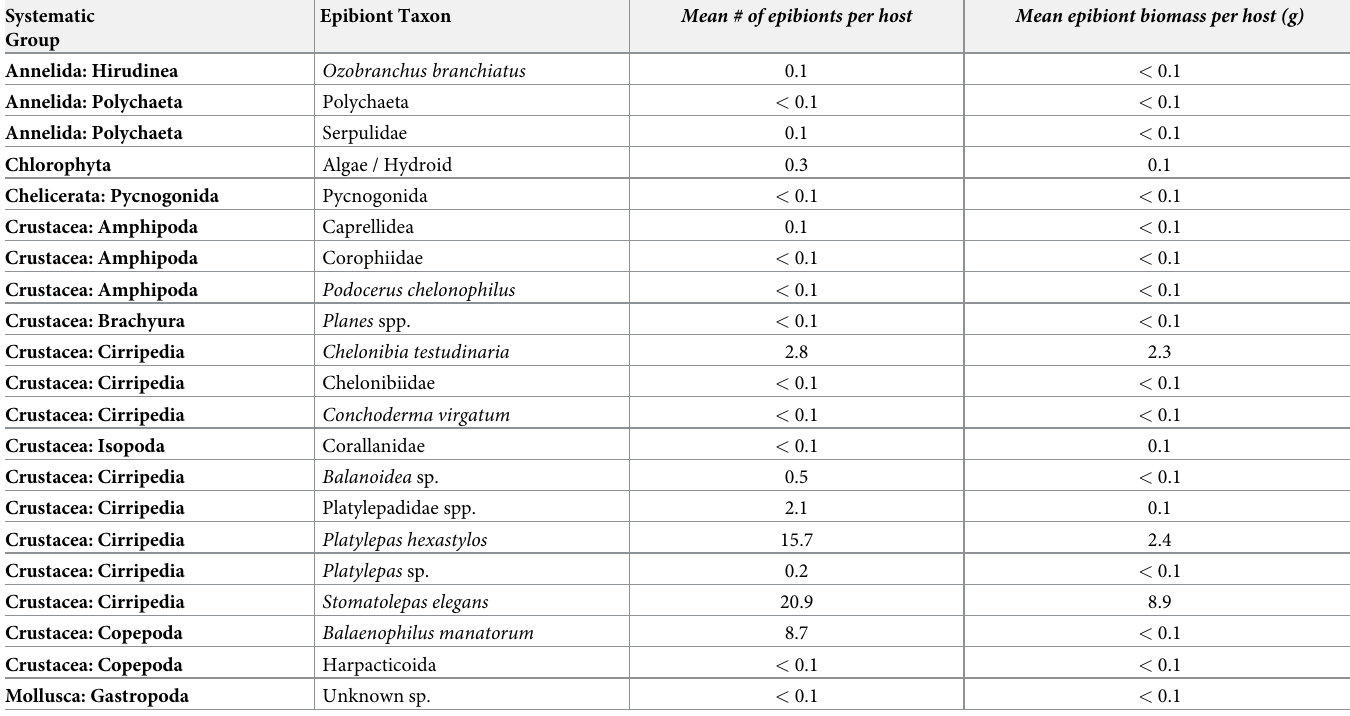
Table 1. Mean # and biomass of the different epibiont species found on 30 olive ridley sea turtles sampled from Playa Ostional, Costa Rica.